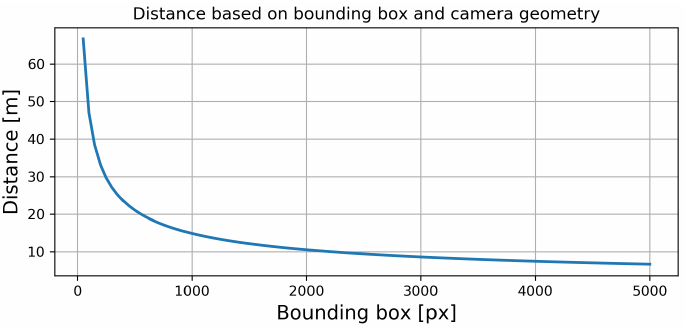
Figure 10. The distance to the person, based on the size of the bounding box, is registered on 416 × 416 pixel